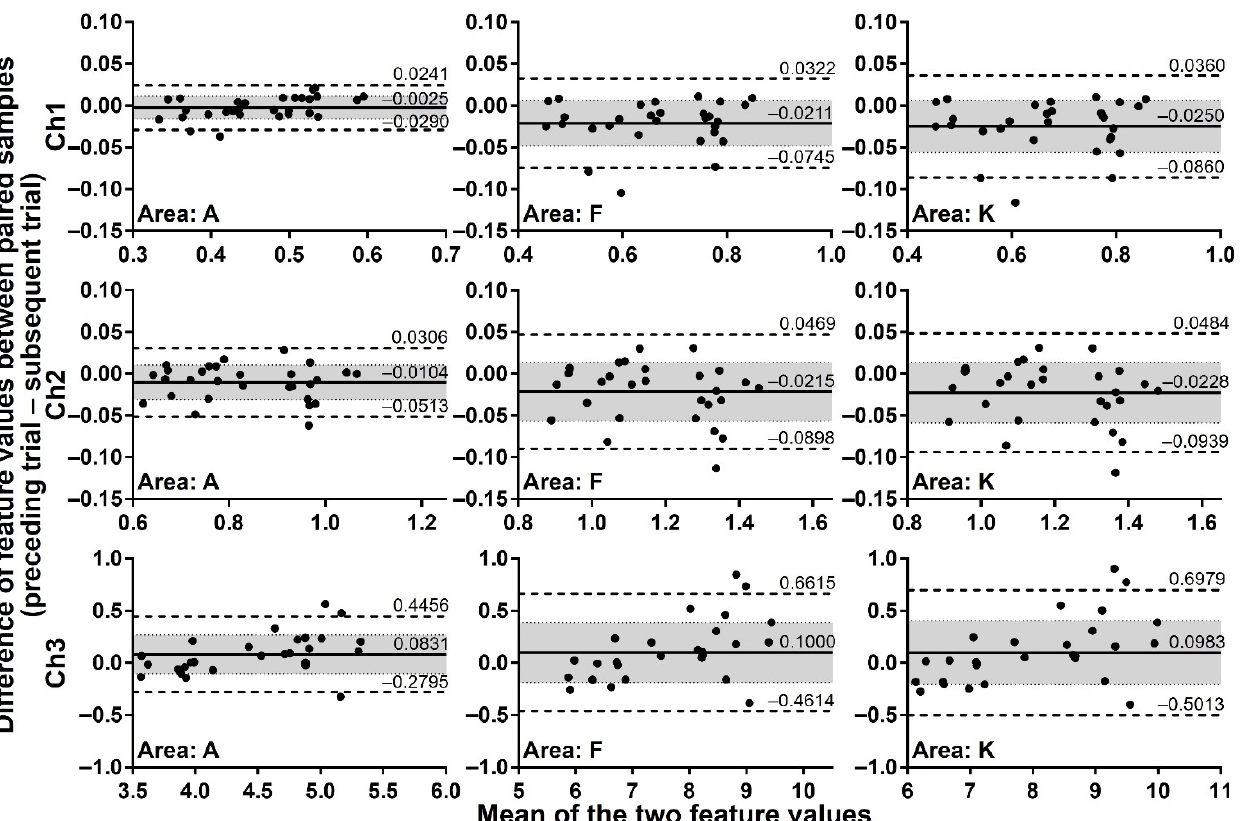
Figure 6. Difference of feature values between paired samples with the difference no more than 0.1% RH. The differences of feature values between 29 paired samples were evaluated by the Bland-Altman plots. Solid lines indicate the bias, and dashed lines correspond to 95% limits of agreement. Shaded areas represent 30% confidence intervals. The results of extraction areas A, F, and K are shown as representative plots.